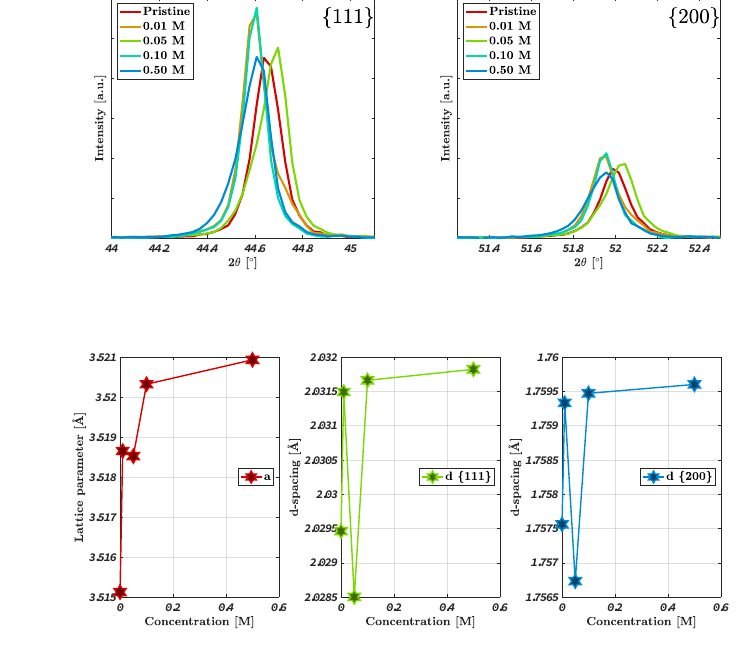
Figure 3. ( a ) XRD spectra of the acid-treated nickel foam electrodes, which are highlighted for the principal peaks related to the 111 and 200 facets, respectively. ( b ) The lattice parameter and d-spacing calculated from the XRD data in ( a ).